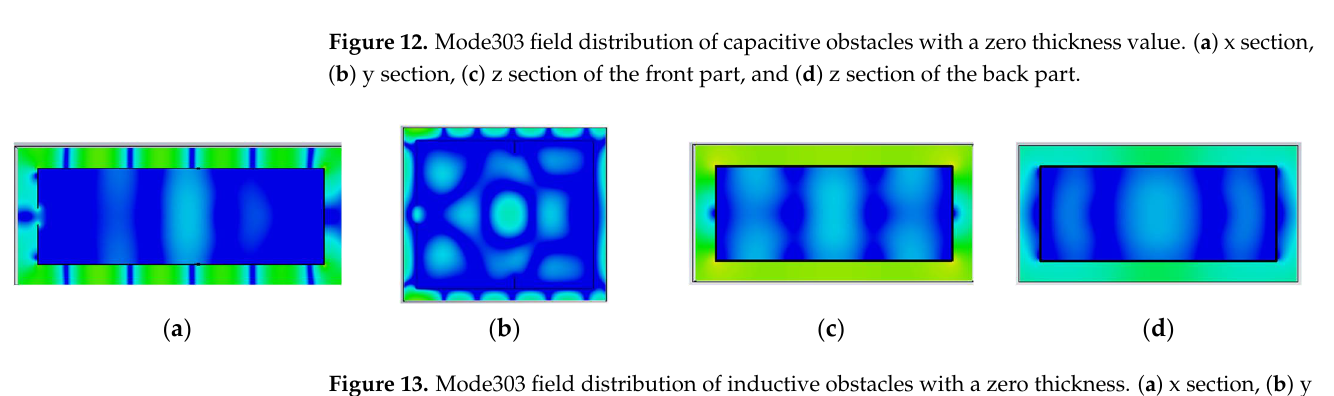
Figure 13. Mode303 field distribution of inductive obstacles with a zero thickness. ( a ) x section, ( b ) y section, ( c ) z section of the front part, and ( d ) z section of the back part.